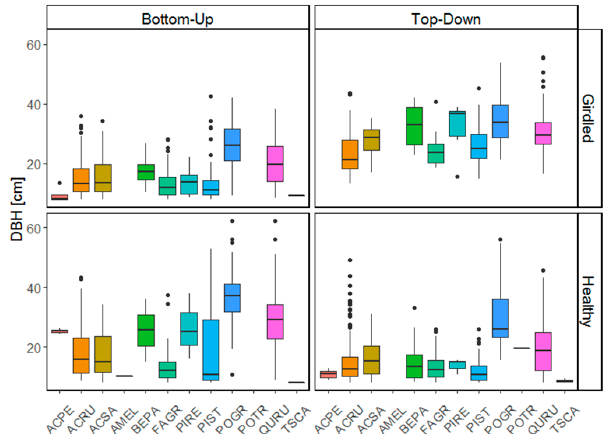
Figure A2. Median (horizontal line), interquartile range (box), 95% confidence intervals (whisker) and outliers (closed circles) of diameter at breast height (DBH) by species for the top-down and bottom-up disturbance type treatments. Species abbreviations are: Abies Balsamea (ABBA), Acer pensylvanicum (ACPE), Acer rubrum (ACRU), Acer saccharum (ACSA), Amelancheir (AMEL), Betula papyrifera (BEPA), Fagus grandifolia (FAGR), Pinus resinosa (PIRE), Pinus strobus (PIST), Populus grandidentata (POGR), Populus tremuloides (POTR), Quercus rubra (QURU), and Tsuga canadensis